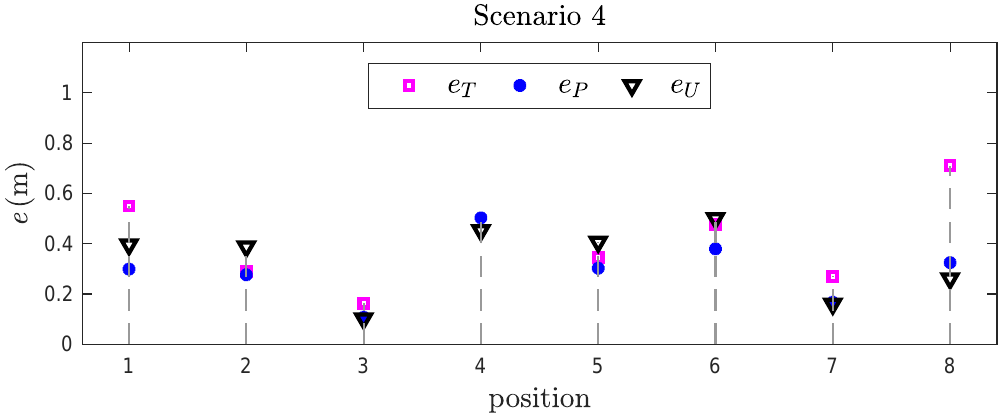
Figure 5. The average errors in Scenario 4 for the TSML algorithm ( e T ), the PSO algorithm ( e P ), and the POST U algorithm ( e U ) are shown in